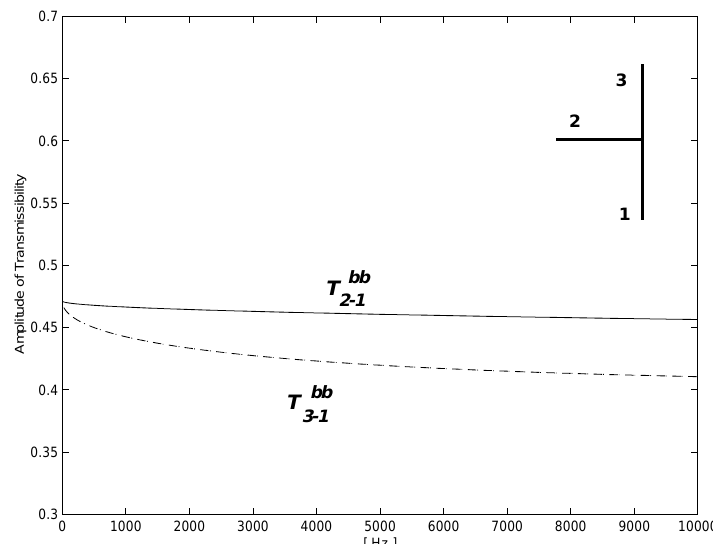
Fig. 3. Transmissibilities for bending waves, both incident and transmitted, between beams 2, 3 and 1 of a junction – beams of equal properties. N = A ( v + ν u ) y j ,y j ,x = α A ( v + u N yx j j ,x ,y